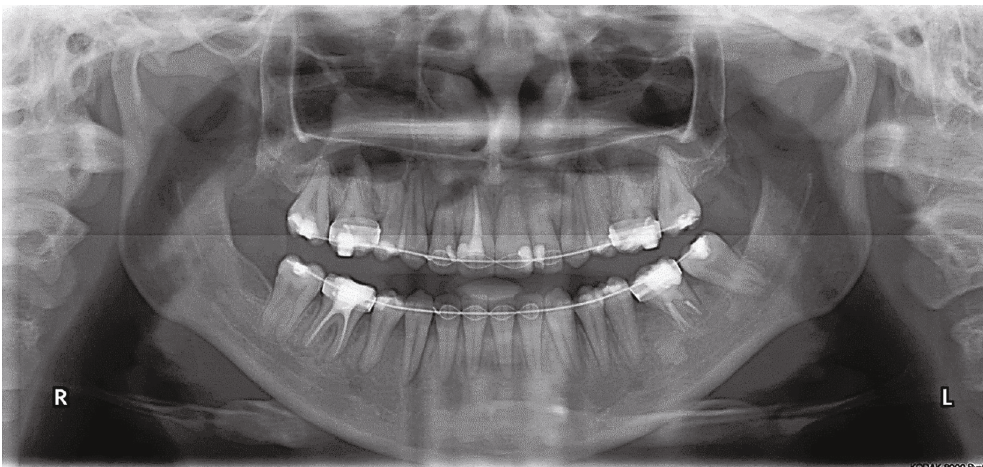
Figure 8: Panoramic radiograph.